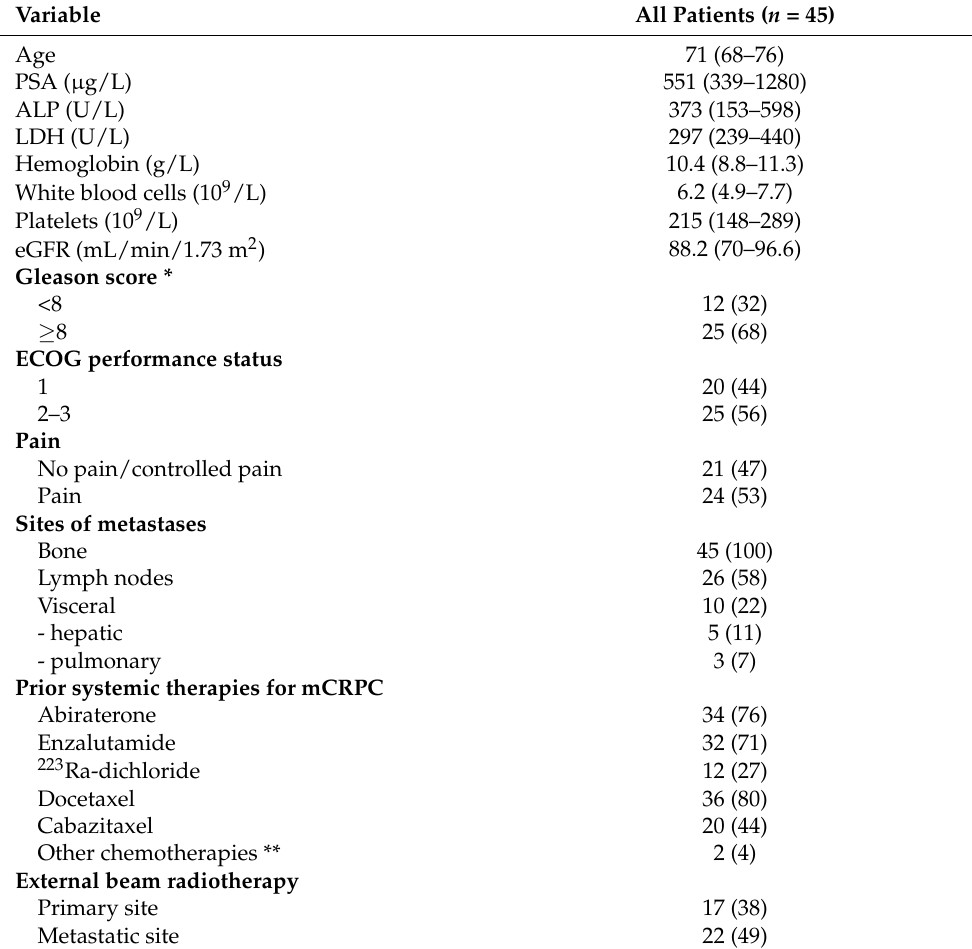
Table 1. Baseline